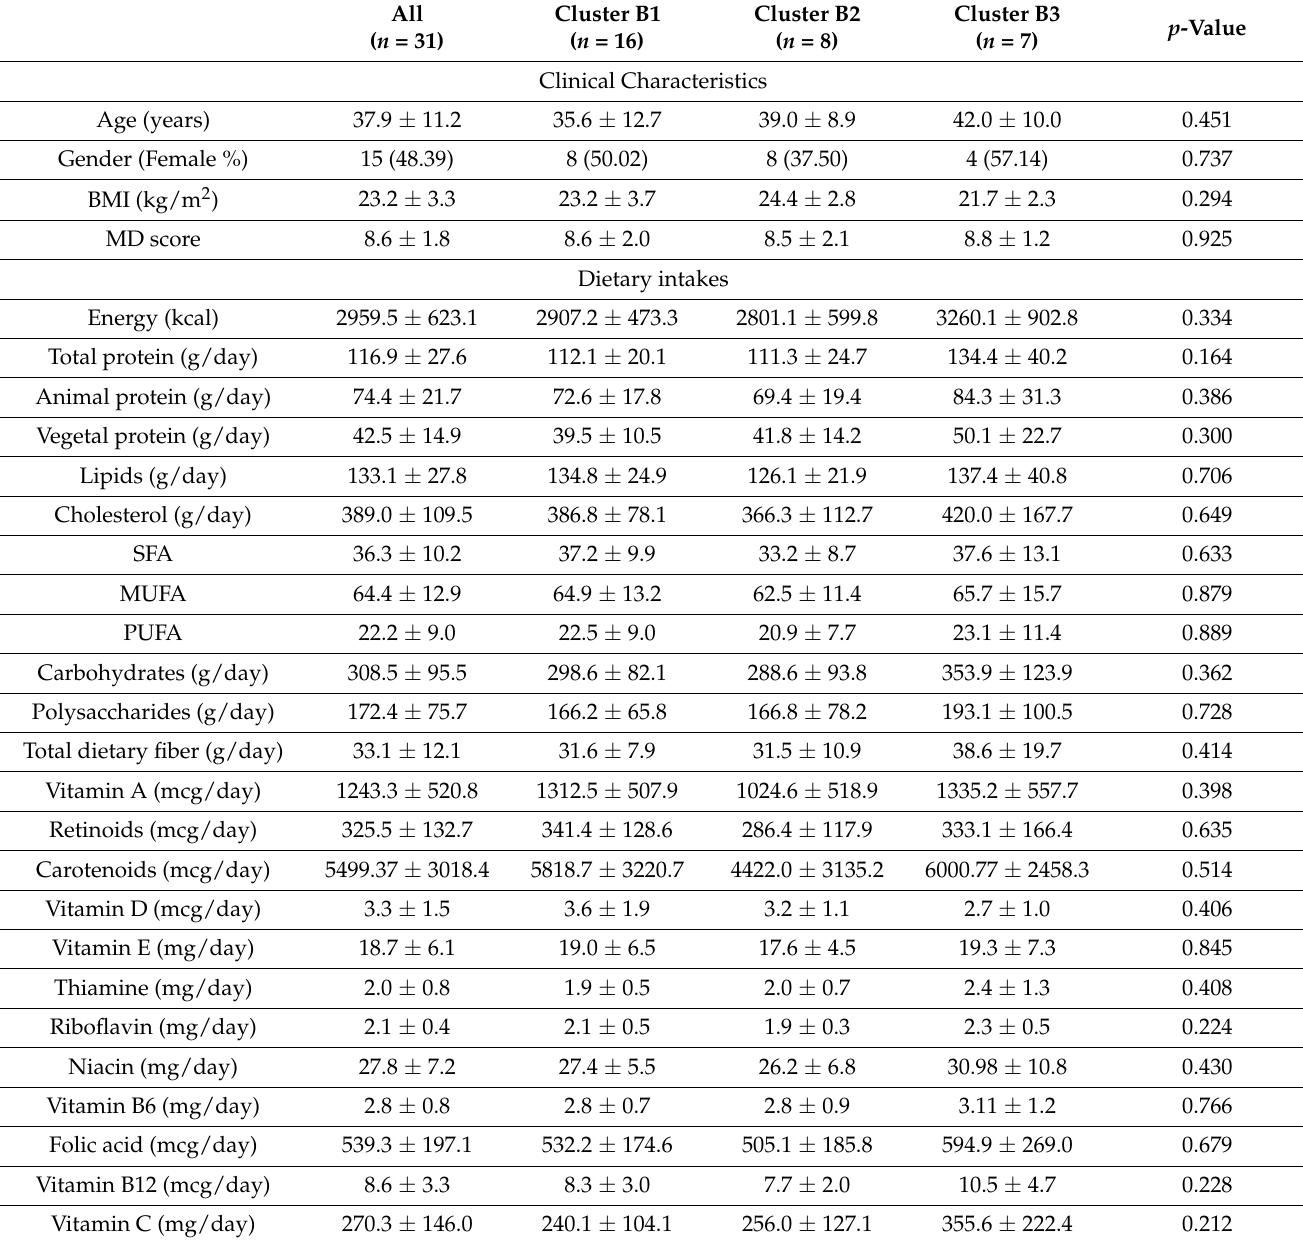
Table 1. Characteristics and specific dietary intake of the healthy volunteers involved in the 3-day intervention